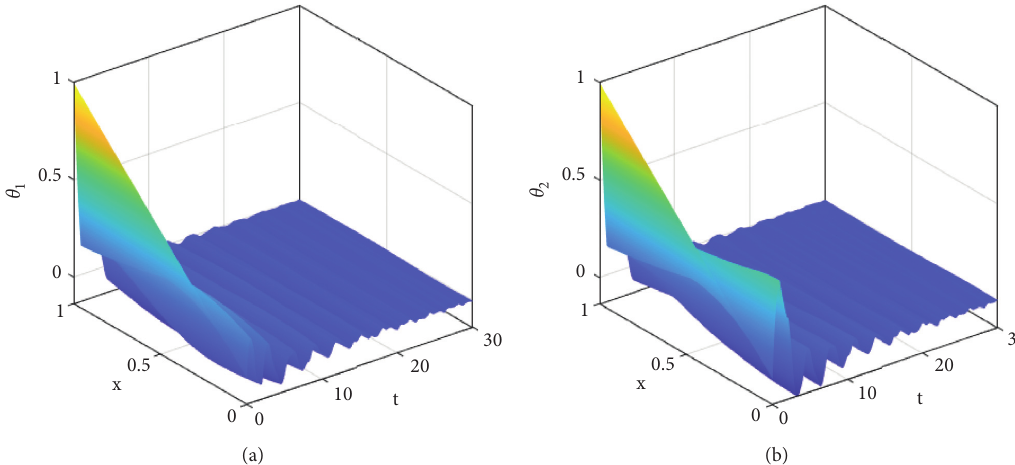
Figure 2: (a) The displacement of θ